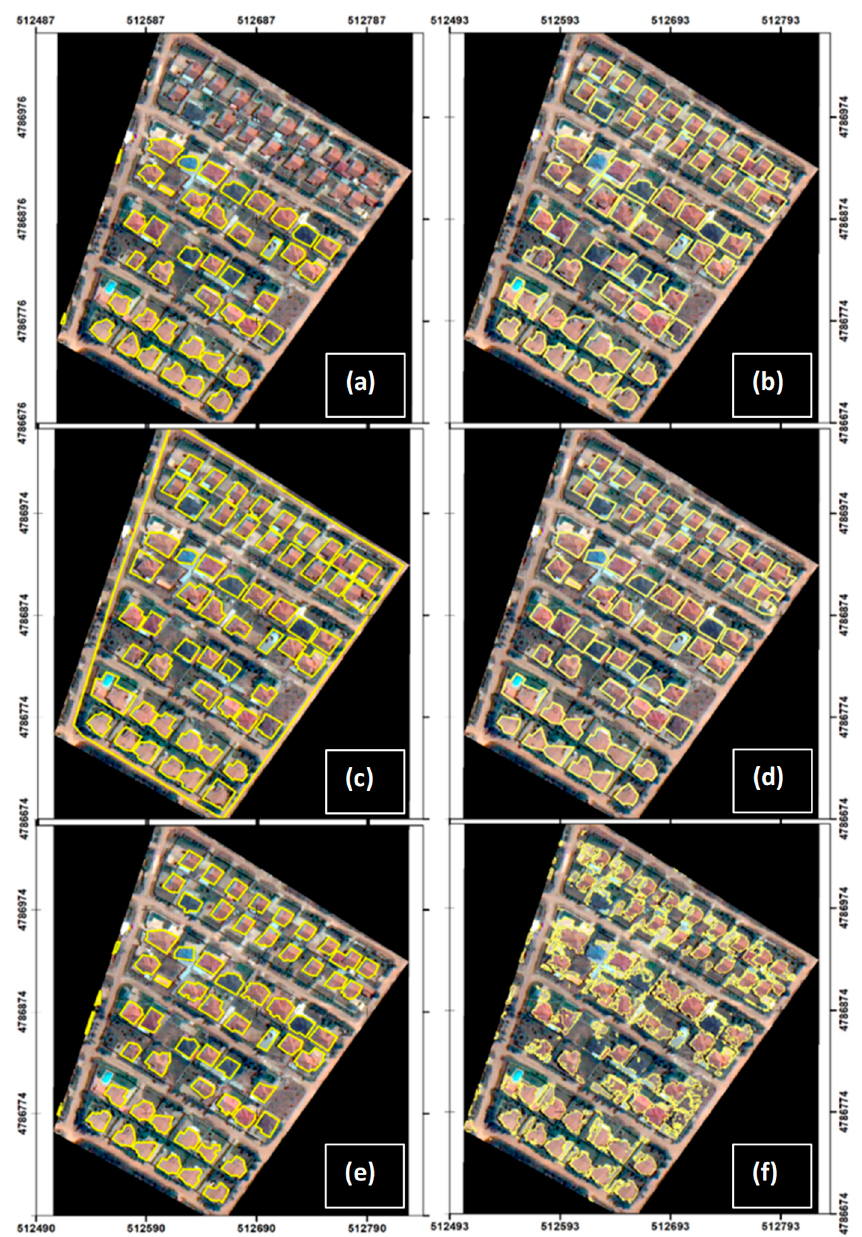
Figure 10. Extracted buildings plots in urban area: ( a – e ) manual digitisation boundaries and ( f ) automation results.